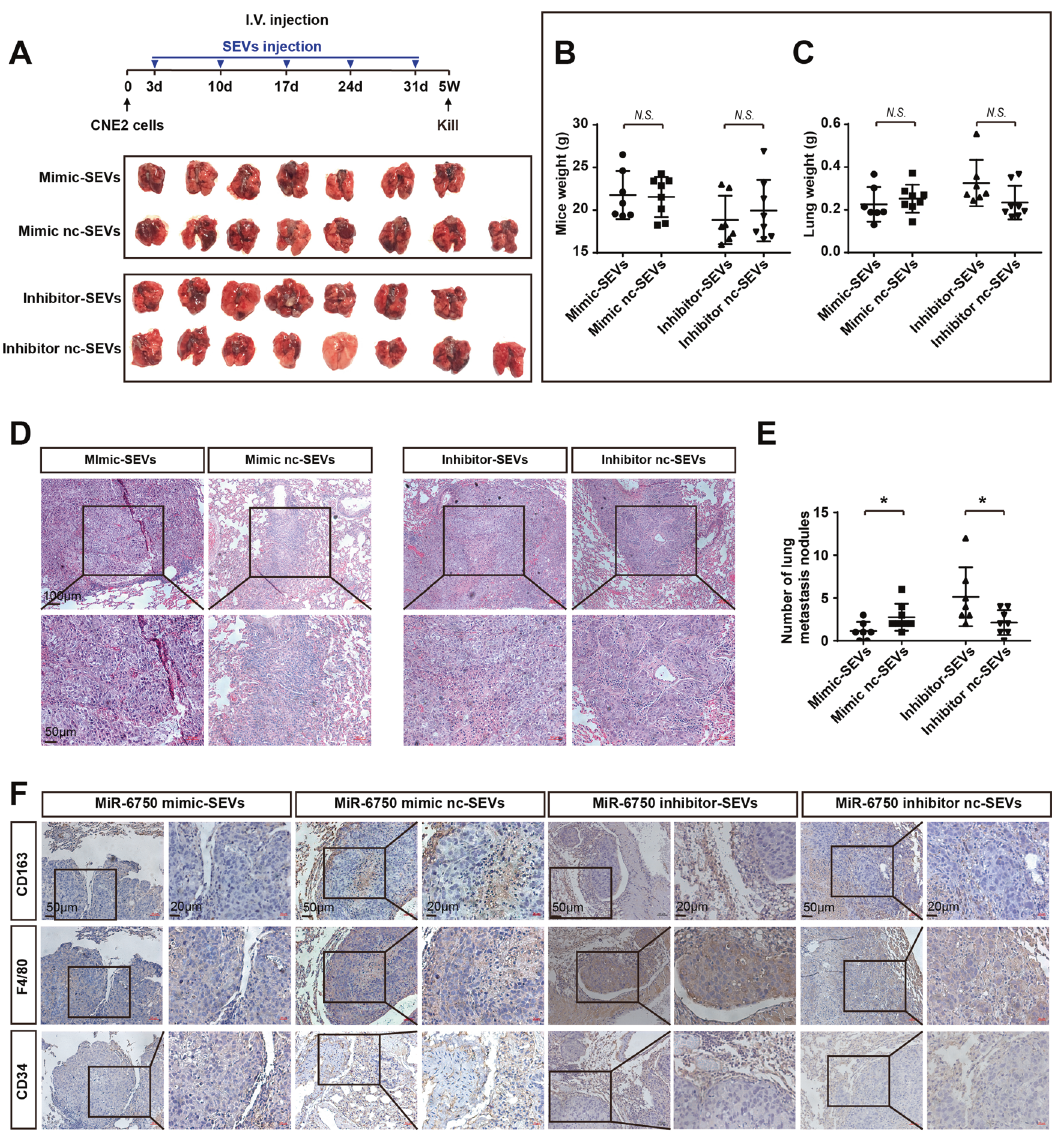
Fig. 6 MiR-6750-SEVs inhibits NPC metastasis by regulating angiogenesis and M2 macrophage in fi ltration. A Schema of animal experiment. BALB/c nude mice receiving 20 μ g of puri fi ed SEVs isolated from CNE2-CM weekly 3 day after CNE2 injection. And gross- observation lung metastasis was showed in graph-depicted groups. B , C Statistical analyses of mice weight and lung weight. Student ’ s t-test. D Representative images of HE staining. E Statistical analyses of Number of lung metastasis nodules in graph-depicted groups. Student ’ s t-test. F Representative images of CD163, F4/80 and CD34 in tissues collected from graph-depicted groups. mice models as shown in Fig. 6A. 5 weeks later, we found that mice injected with miR-6750-overexpressing SEVs dramatically decreased number of lung metastasis nodules, whereas mice weight and lung weight showing no difference (Fig. 6B – E), indicating that miR-6750-SEVs inhibited NPC metastasis in vivo. Additional IHC assay revealed that there were higher M2 macrophage in fi ltration and higher density of MVD in mice with low miR-6750 SEVs vs. high miR-6750 SEVs (Fig. 6F), in turn, supports our conjecture that miR-6750-SEVs regulate NPC metastasis through the establishment of anti-metastatic niche.